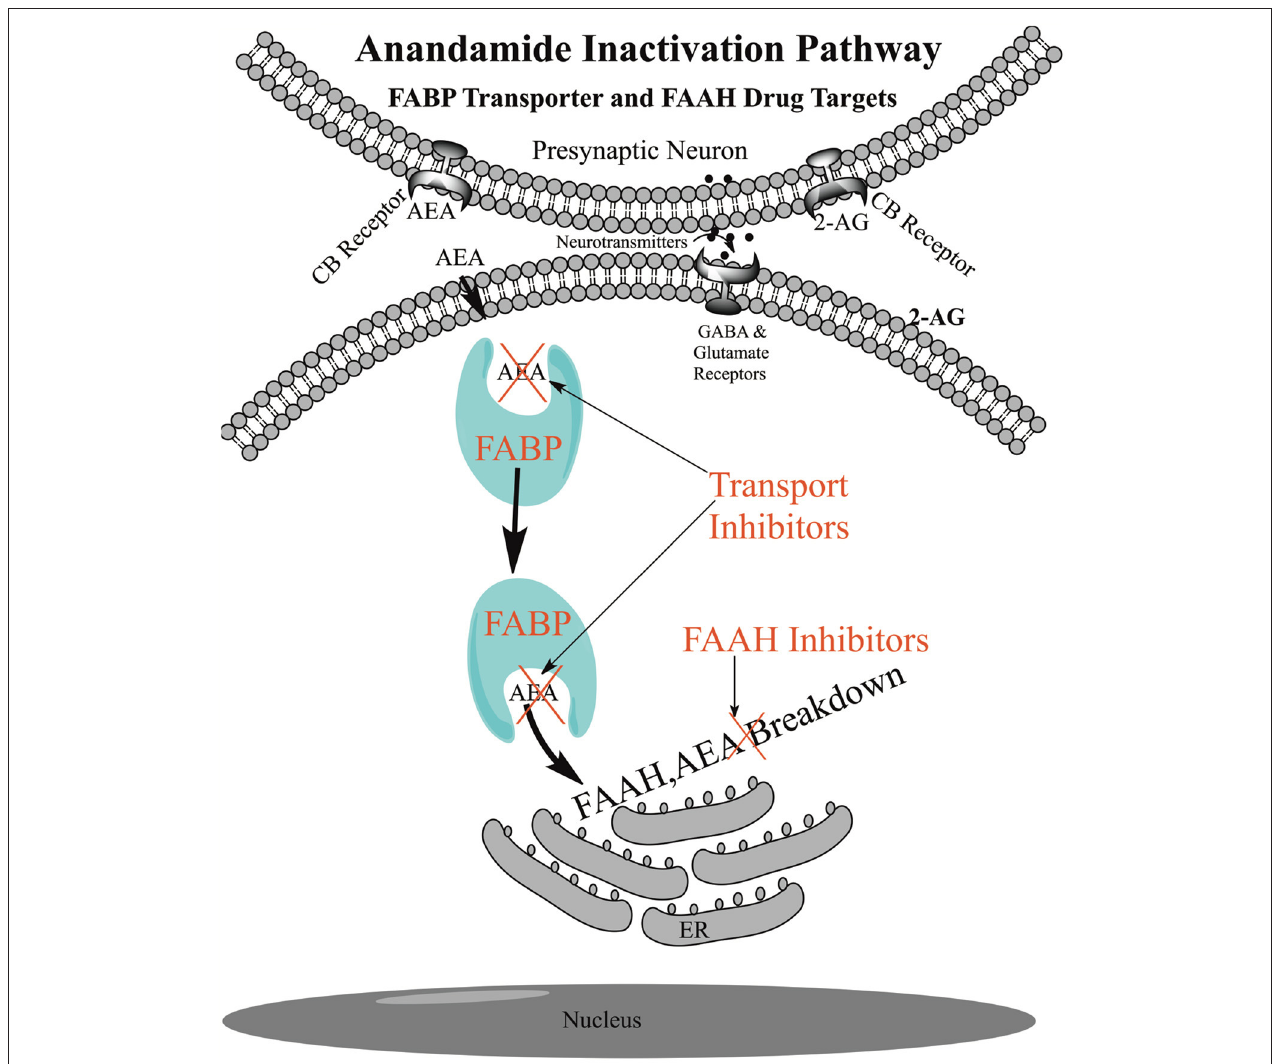
FIGURE 2 | Schematic of Anandamide Uptake and Inactivation. Endogenous anandamide (AEA) passes through the cellular membrane without the need for a protein transporter and is shuttled through the aqueous environment of the cytoplasm with the fatty acid binding protein transporters (FABPs) to endoplasmic reticulum (ER) localized fatty acid amide hydrolase (FAAH) for catabolism. FAAH drives the uptake and inhibition of FAAH or the FABPs reduces the rate of anandamide breakdown and raises the AEA levels for signaling at the